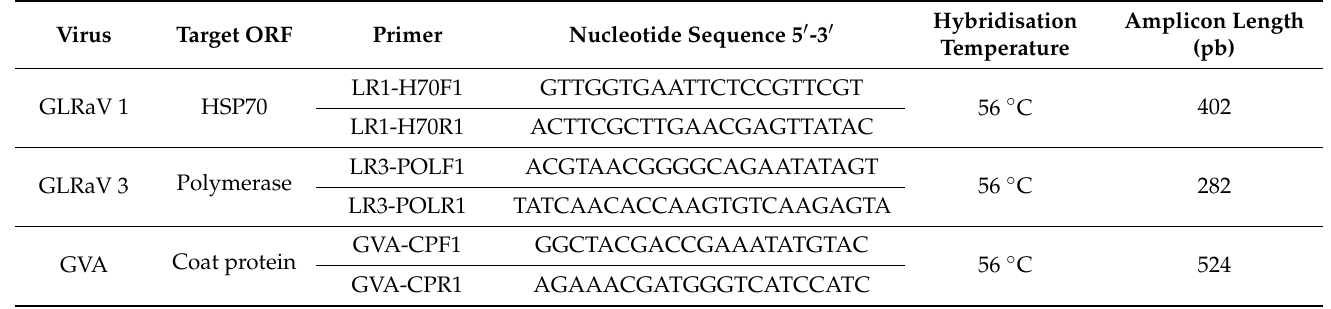
Table 2. Sequences of the primers used for the amplification of GLRaV 1, 3 and GVA by multiplex RT-PCR. The primers were designed in conserved sequences among isolates of each virus available in the GenBank (NCBI) database (Beuve et al., 2013